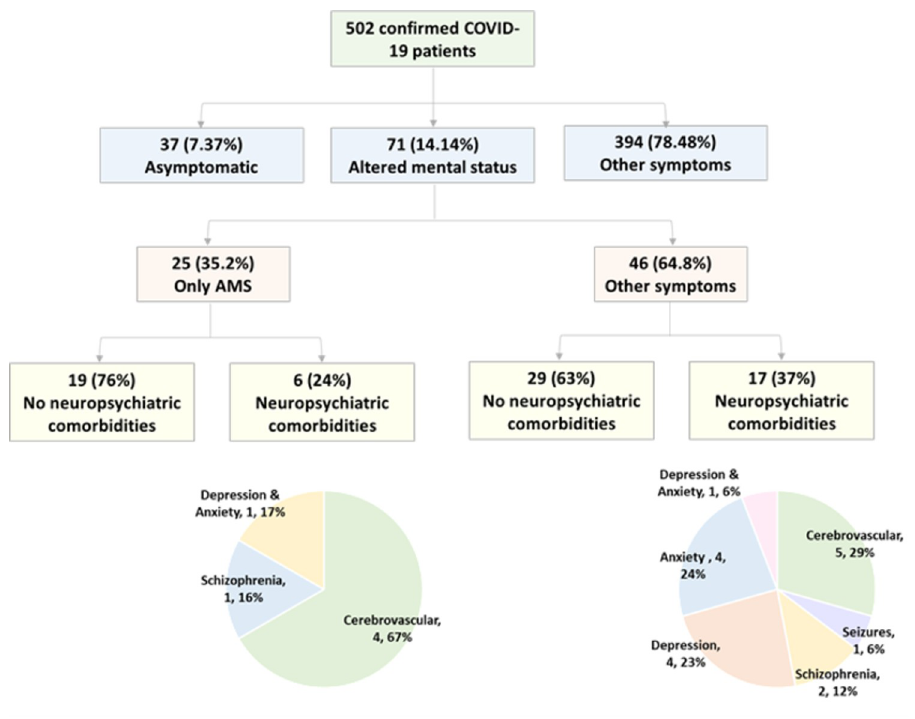
Fig 1. Hierarchical classification of patients according to neuropsychiatric symptoms and